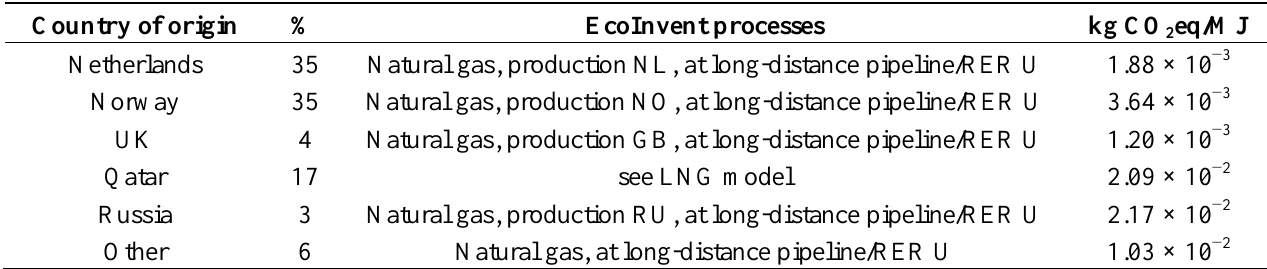
Table 2. Natural gas supply mix in Belgium [40].